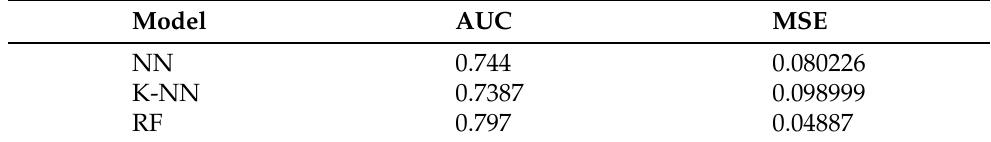
Table 10. Classification results of the three basic models for the tested dataset.